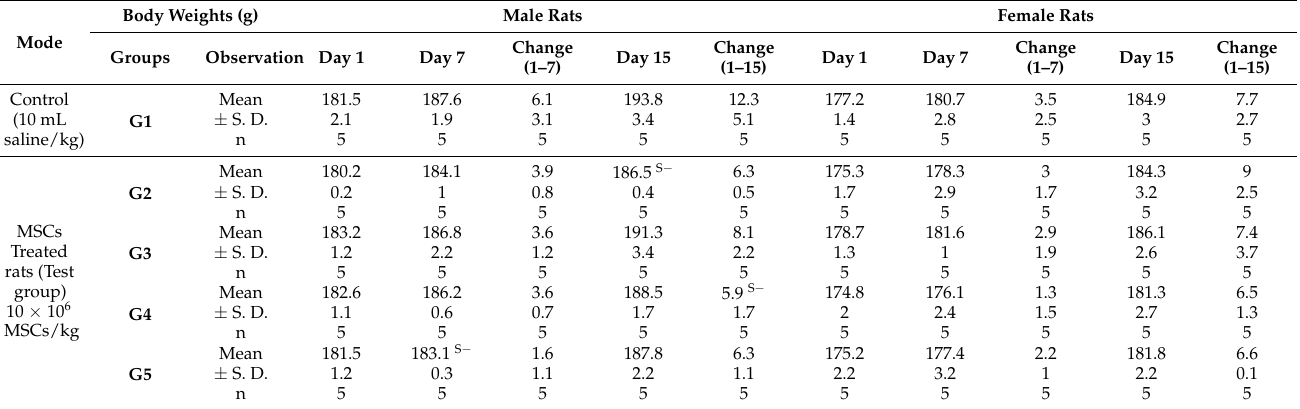
Table 2. Summary of male and female rat body weights after intravenous and subcutaneous